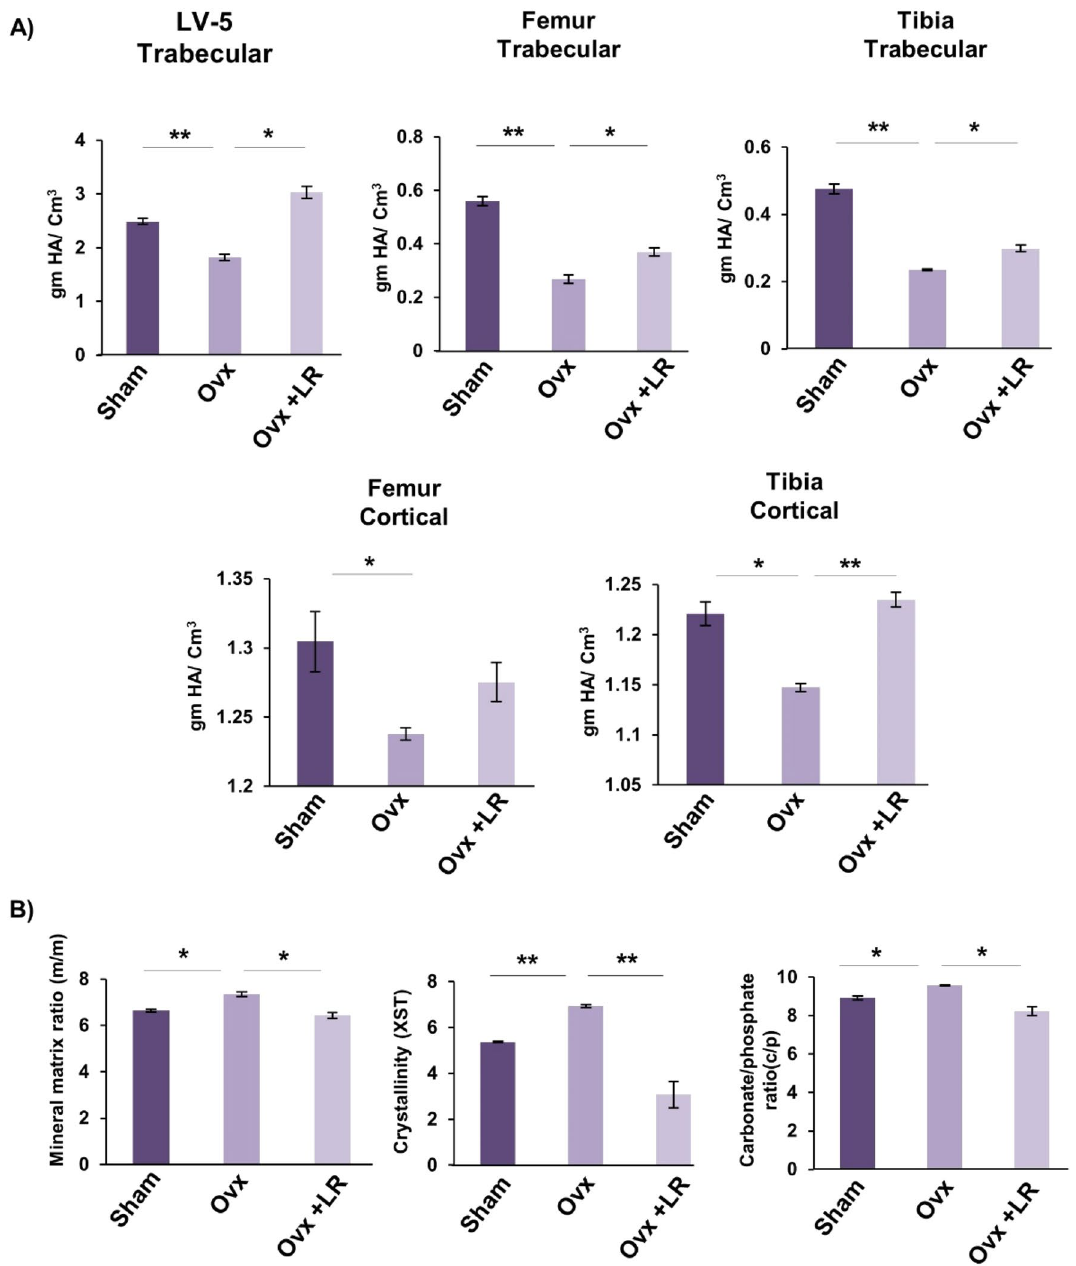
Figure 7. LR administration enhances bone mineral density and heterogeneity of bones. ( A ) Graphical representation of BMD of LV-5, trabecular and cortical regions of femur and tibial bones of all groups. ( B ) Graphical representation of compositional changes in bones as detected by FTIR (bone mineral/organic matrix ratio (m/m), crystallinity (XST) and carbonate to phosphate ratio (C/P). Data are reported as mean ± SEM. Similar results were obtained in two independent experiments with n = 6. Statistical significance of each parameter was assessed by ANOVA followed by paired group comparison. * p < 0.05, ** p < 0.01, *** p < 0.001 compared with indicated augmentation of anti-osteoclastogenic cytokines IL-10 ( p < 0.01), IL-4 ( p < 0.05) and IFN-γ ( p < 0.01) (Fig. 10) as compared to Ovx mice group. Taken together our data strongly supports that LR-administration in Ovx mice leads to enhanced bone health via skewing the cytokine balance. In summary, our findings indicate a crucial role of LR in both bone metabolism and immune responses in attenuating bone loss in postmenopausal osteoporotic condition.